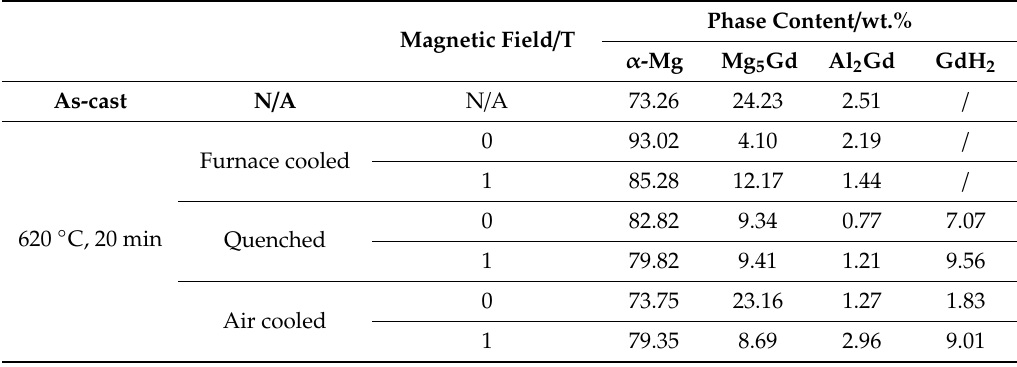
Table 1. Weight percentage of the Mg–Al–Gd alloys homogenized under 0 T and 1 T, followed by furnace cooling, quenching, and air